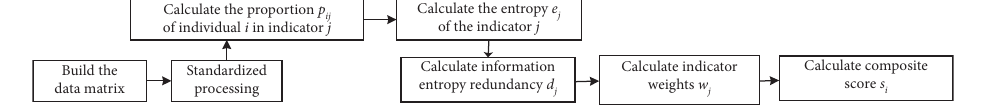
Figure 2: RSR method